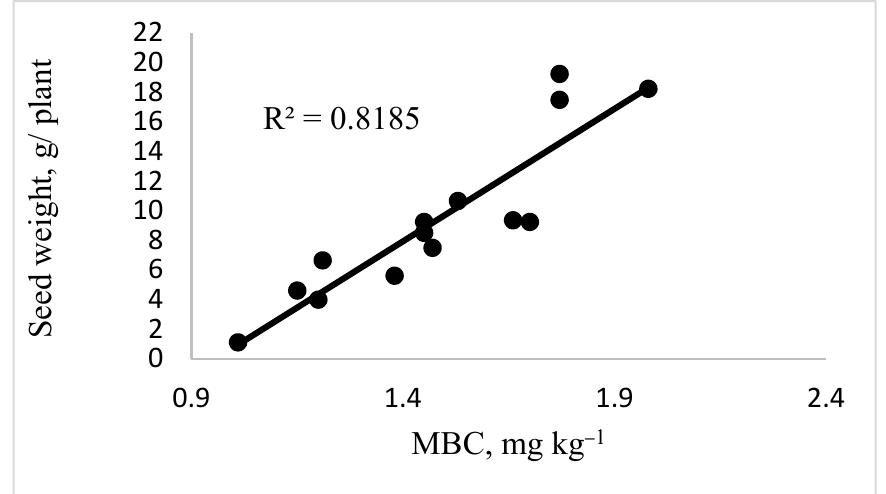
Figure 6. Relationship between MBC and seed weight of canola.